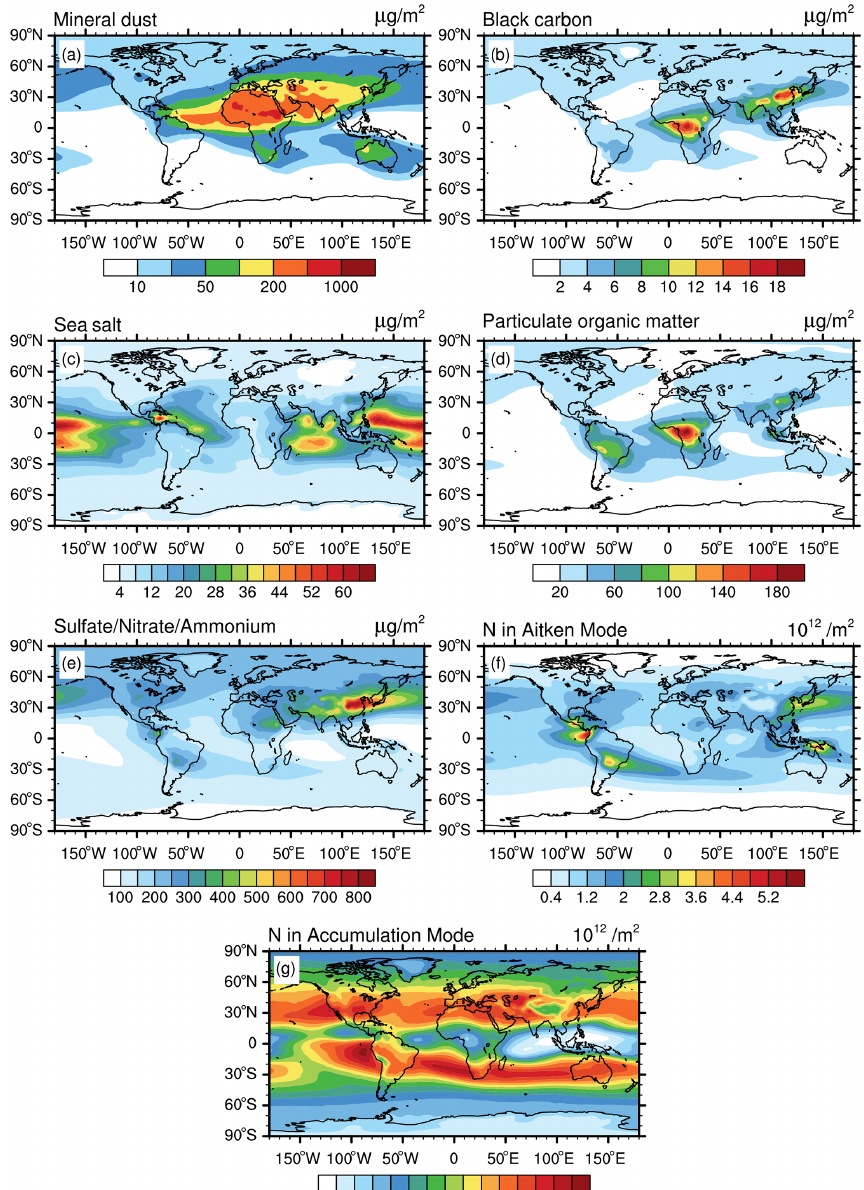
Figure 5. The same as Fig. 1 but for the tropopause region (from ∼ 300 to ∼